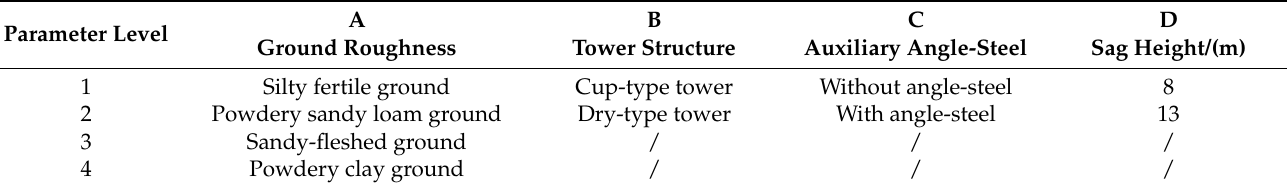
Table 5. Experimental results and calculations of the joint model at 10 MHz incident